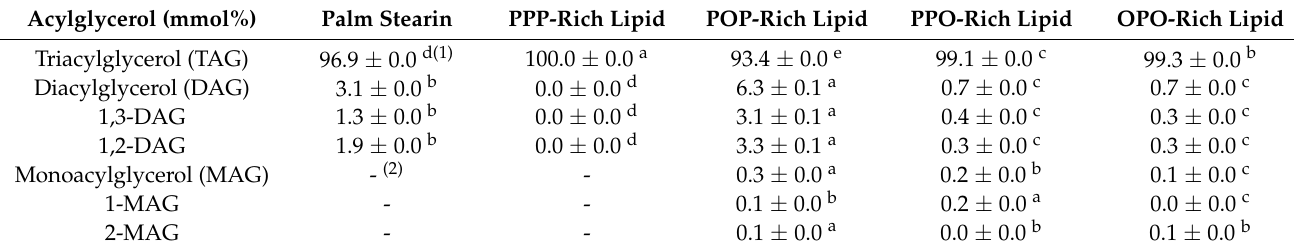
Table 1. Acylglyerol composition of the